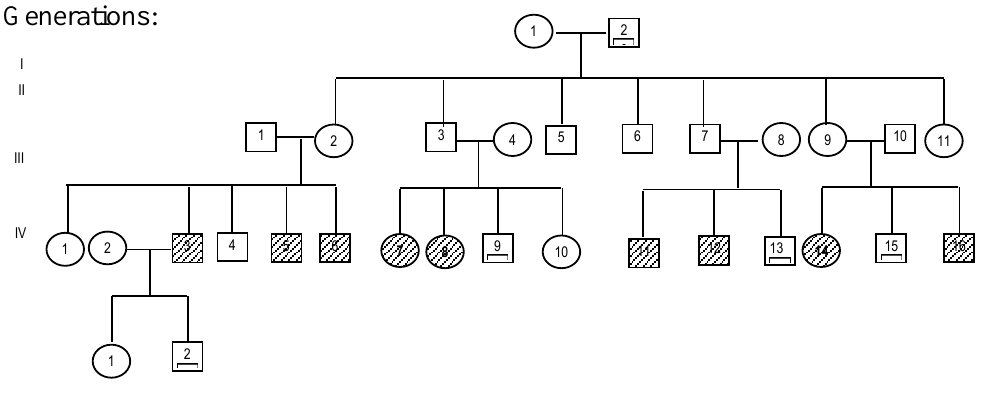
Figure 1. The Inheritance Pattern of Albinism in Desa Adat